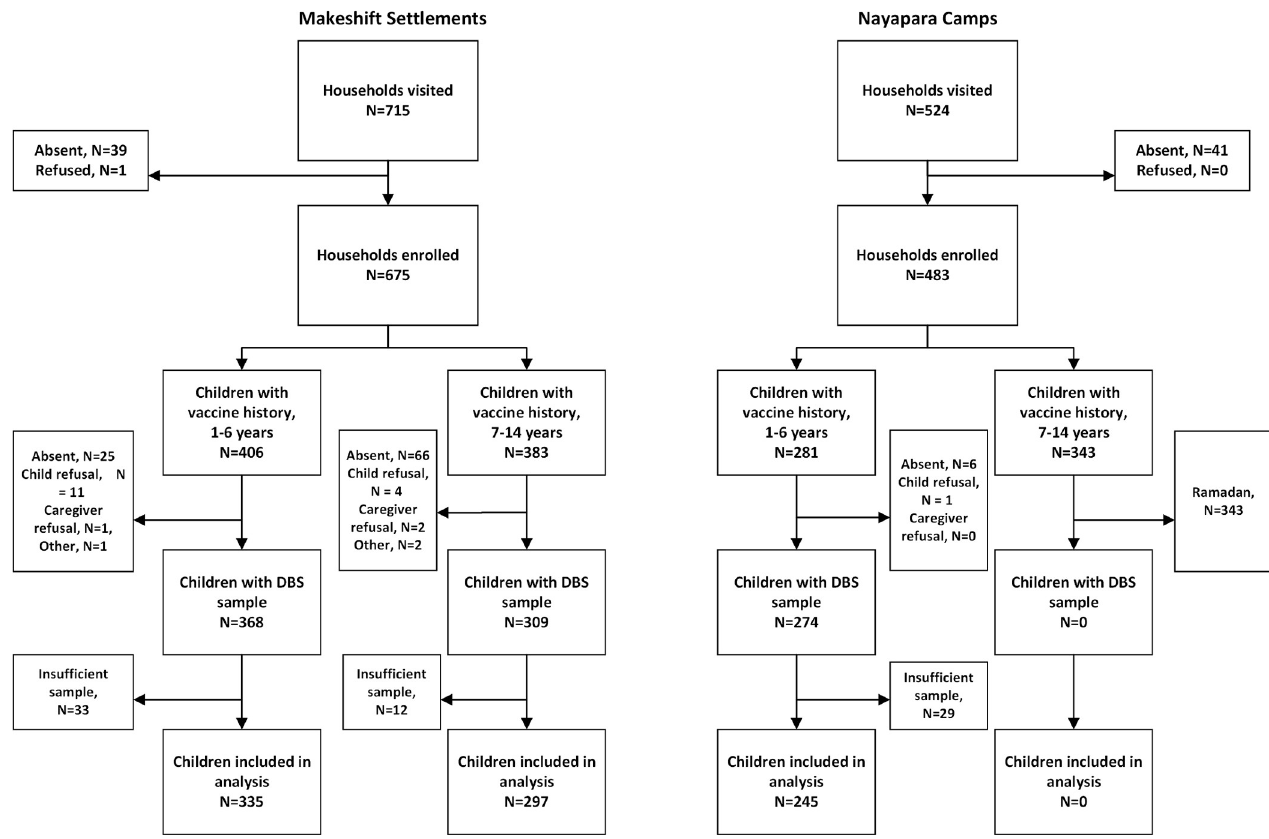
Fig 1. Sample selection among Rohingya children in Cox’s Bazar, Bangladesh, April–May 2018. DBS, dried blood spot.